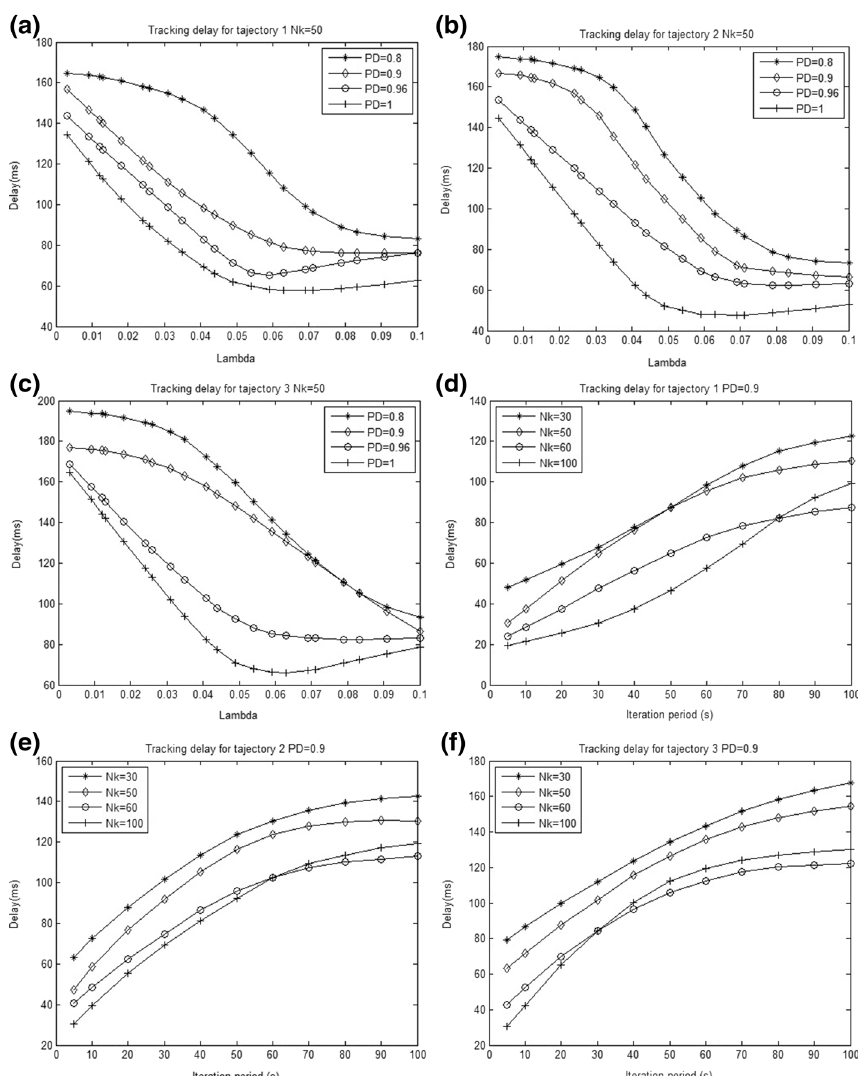
Fig. 5 a – c Tracking delay related to detected probability p D based on node density (cid:31) 0 . a Trajectory 1; b Trajectory 2; c Trajectory 3; d – f Tracking delay related to samples N k based on iteration periods. d Trajectory 1; e Trajectory 2; f Trajectory